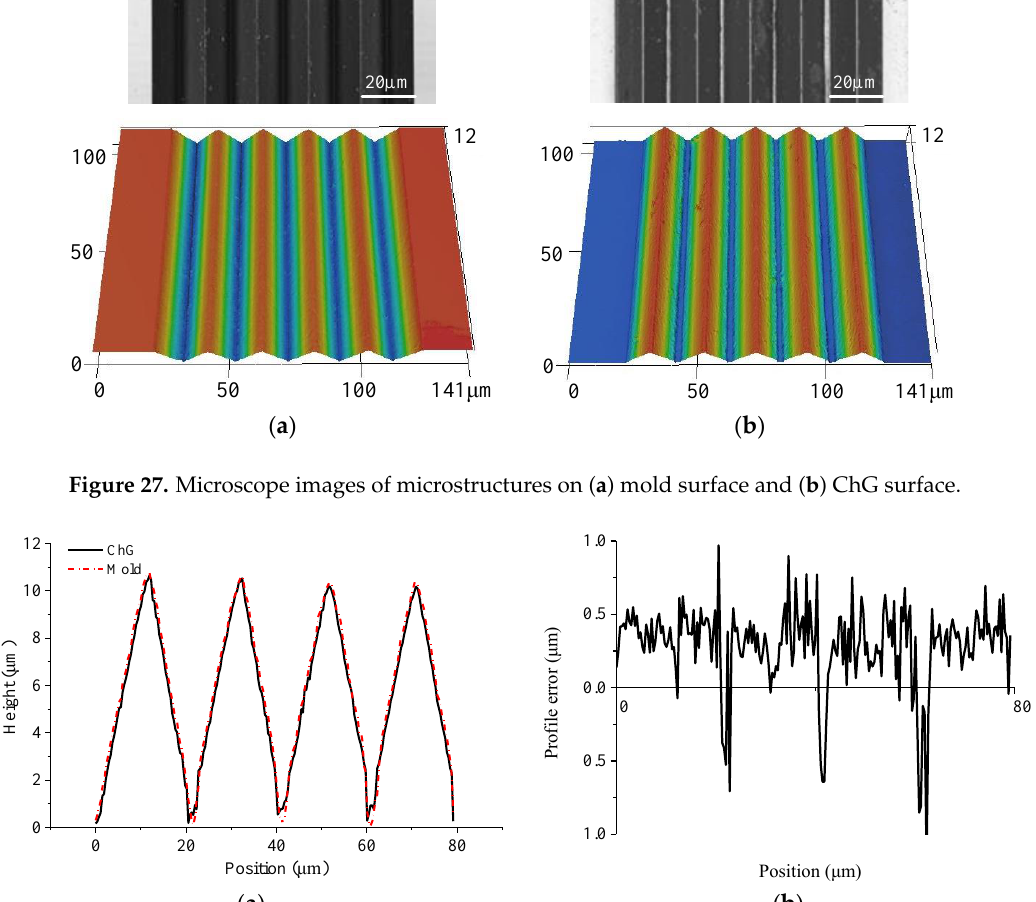
Figure 28. The profile curves of microstructures: ( a ) microstructures on the mold and the ChG, and ( b ) profile error of microstructures.